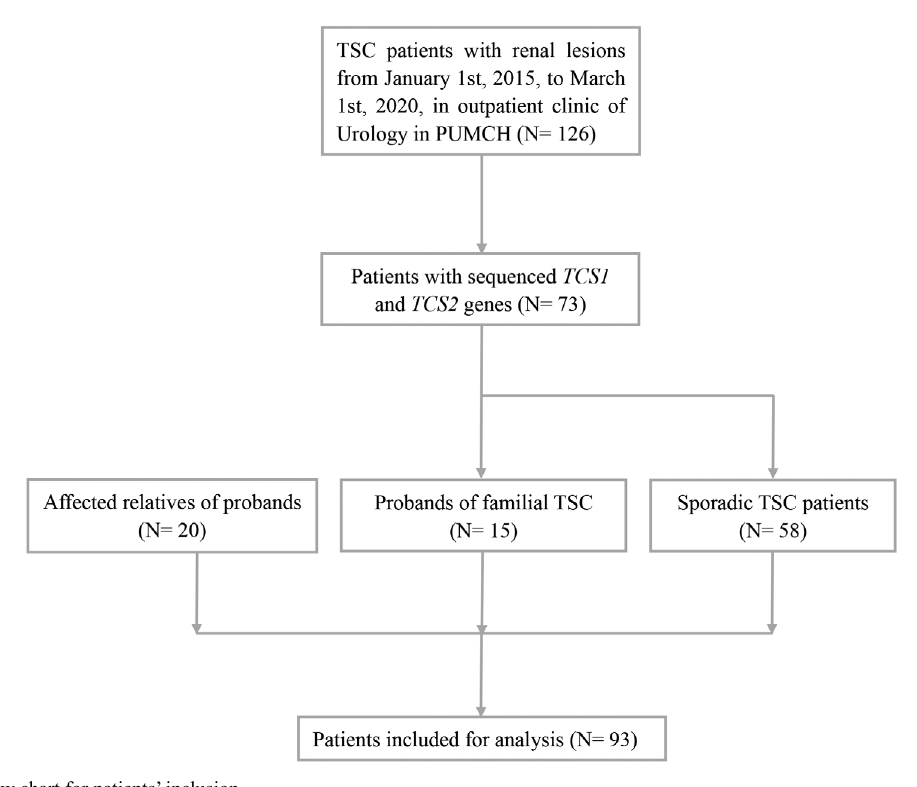
Figure 1 - The flow chart for patients’ inclusion. Table 2 - Clinical characteristics of the 93